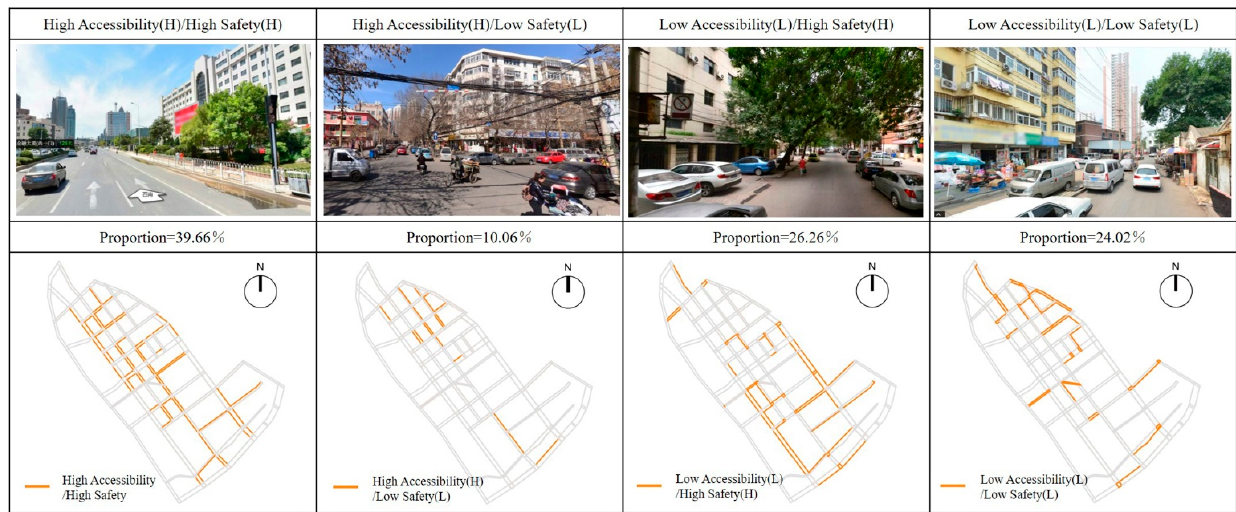
Figure 15. Typical Street scenes and distributions of the four types of